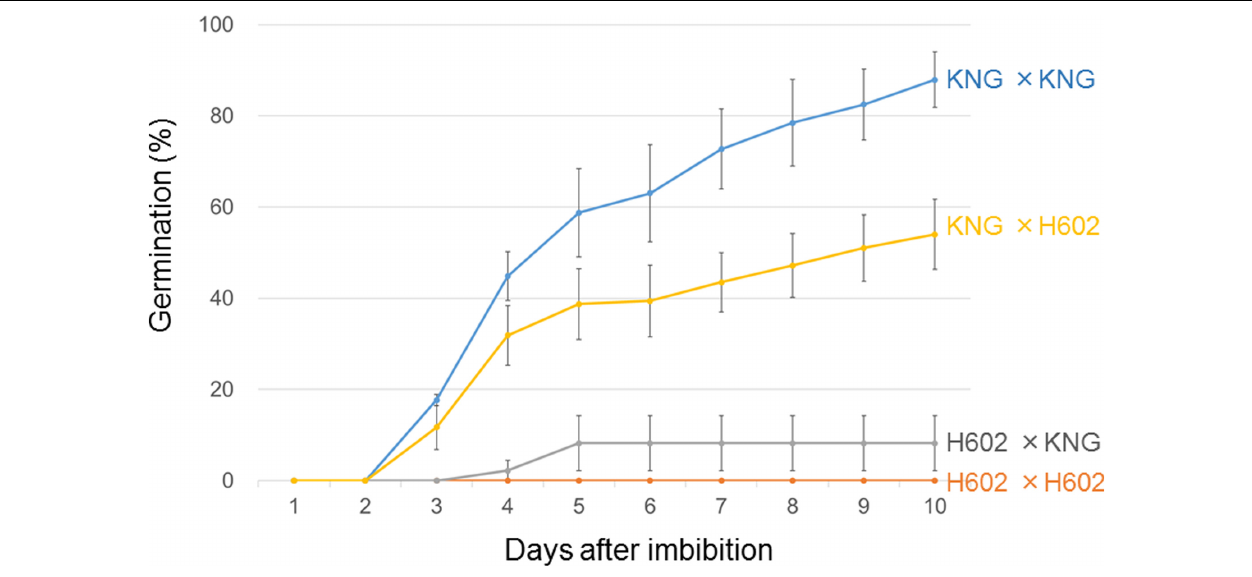
FIGURE 4 | Germination of F 1 progenies derived from reciprocal crosses between H602 and KNG. Orange line: H602 × H602. Gray line: H602 (as female) × KNG (as male). Yellow line: KNG (as female) × H602 (as male). Blue line: KNG × KNG. Circles: mean germination percentages. Vertical bars: standard deviation. n = 3